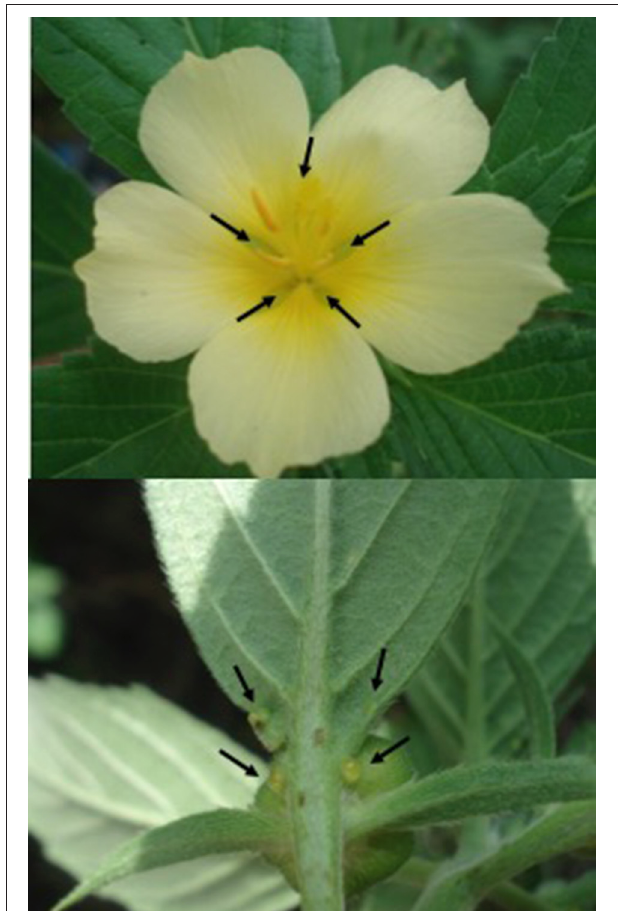
FIGURE 1 | Flower of Turnera velutina (top) with arrows indicating the location of the floral nectaries at the base of the corolla, between the petals, and leaves (bottom) with arrows indicating the location of extrafloral nectaries, on the underside of the